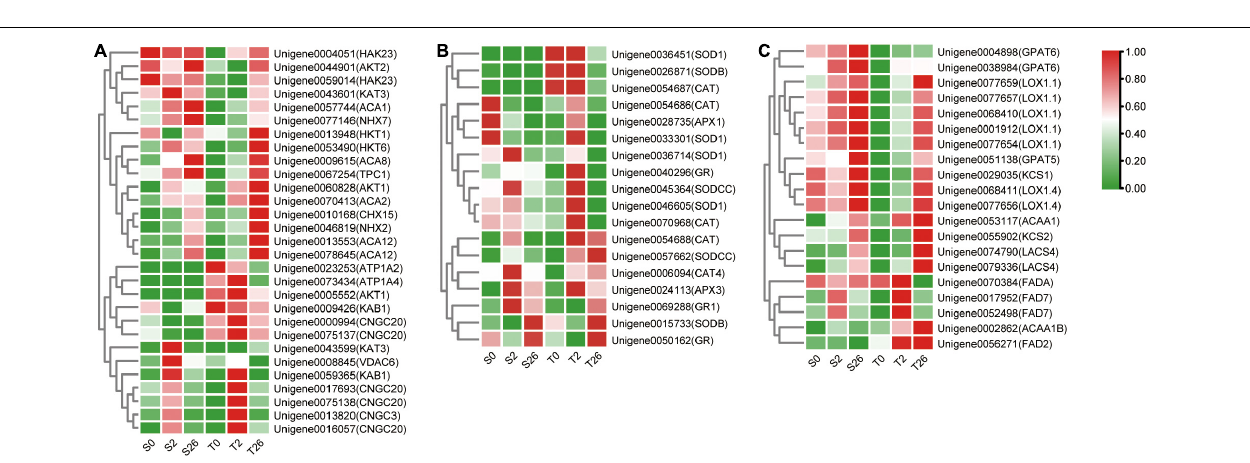
FIGURE 7 | Differentially expressed genes (DEGs) in Magnum Salt (T) and Adrenalin (S) under salt stress. (A) Number of upregulated and downregulated DEGs under salt stress. (B) Venn diagram analysis of the DEGs in different comparison groups of S0-vs-S2, S0-vs-S26, T0-vs-T2 and T0-vs-T26.